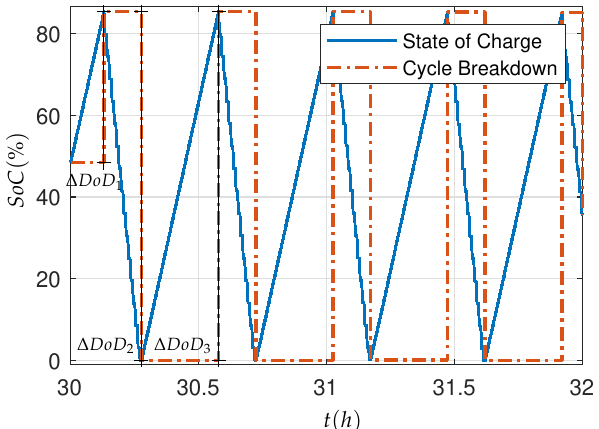
Figure 5. Example of feature extraction procedure ( ∆ DoD and ω ∆ DoD ) from the SoC signal with a rainflow counting algorithm. Table 4: Extracted Features